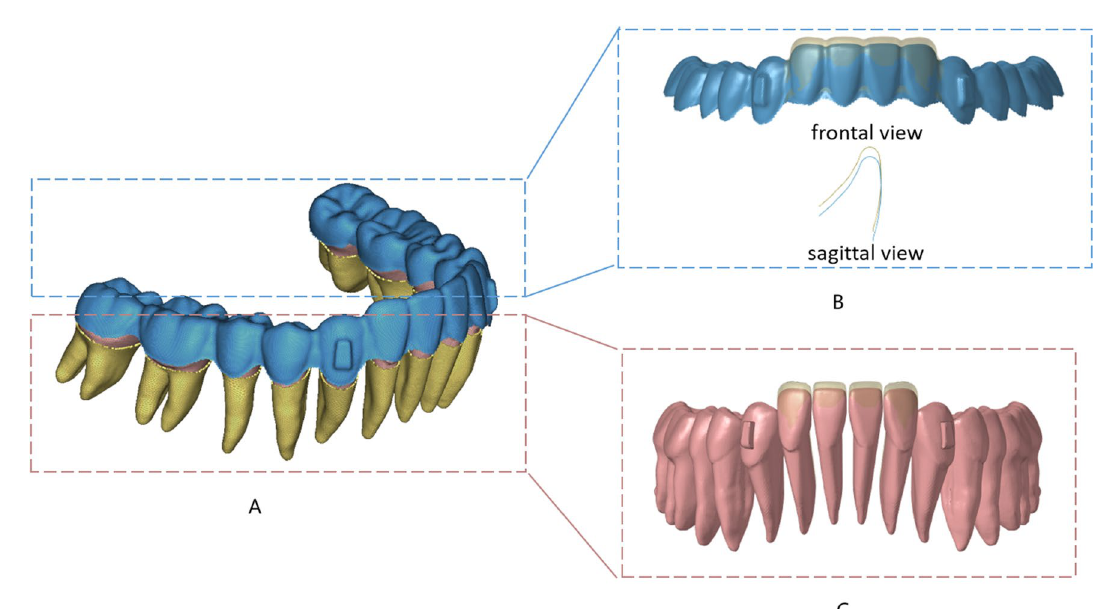
Fig. 2 FE model and intrusion design. A CA including rectangular attachments on the labial surfaces of mandibular canines (blue), teeth (pink), PDL (yellow). B Aligner before (yellow) and after (blue) the mandibular incisors were simultaneously intruded by 0.2 mm. C Dentition before (yellow) and after (pink) the mandibular incisors were simultaneously intruded by 0.2